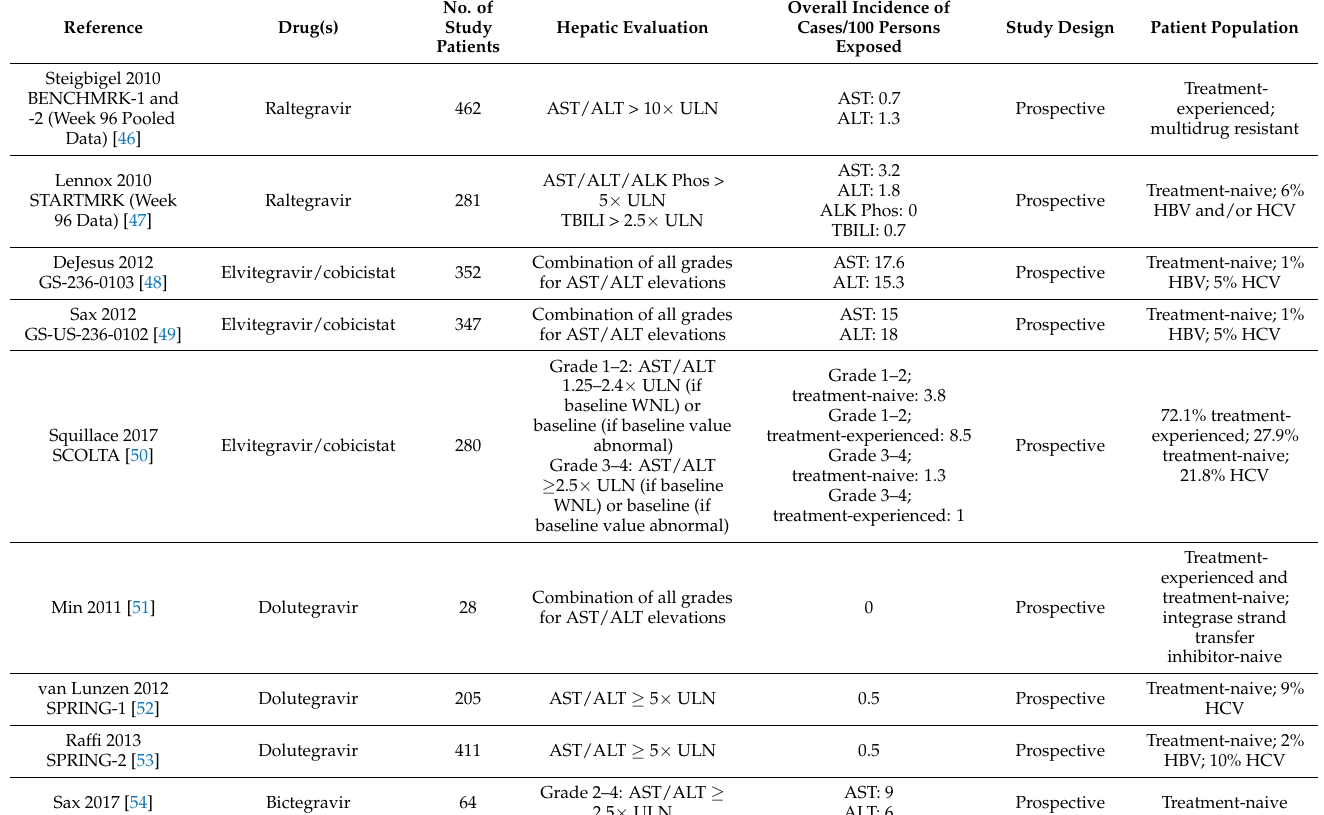
Table 4. Clinical trial evaluation of hepatic toxicity and incidence for integrase strand transfer inhibitors. Reference Hepatic Evaluation